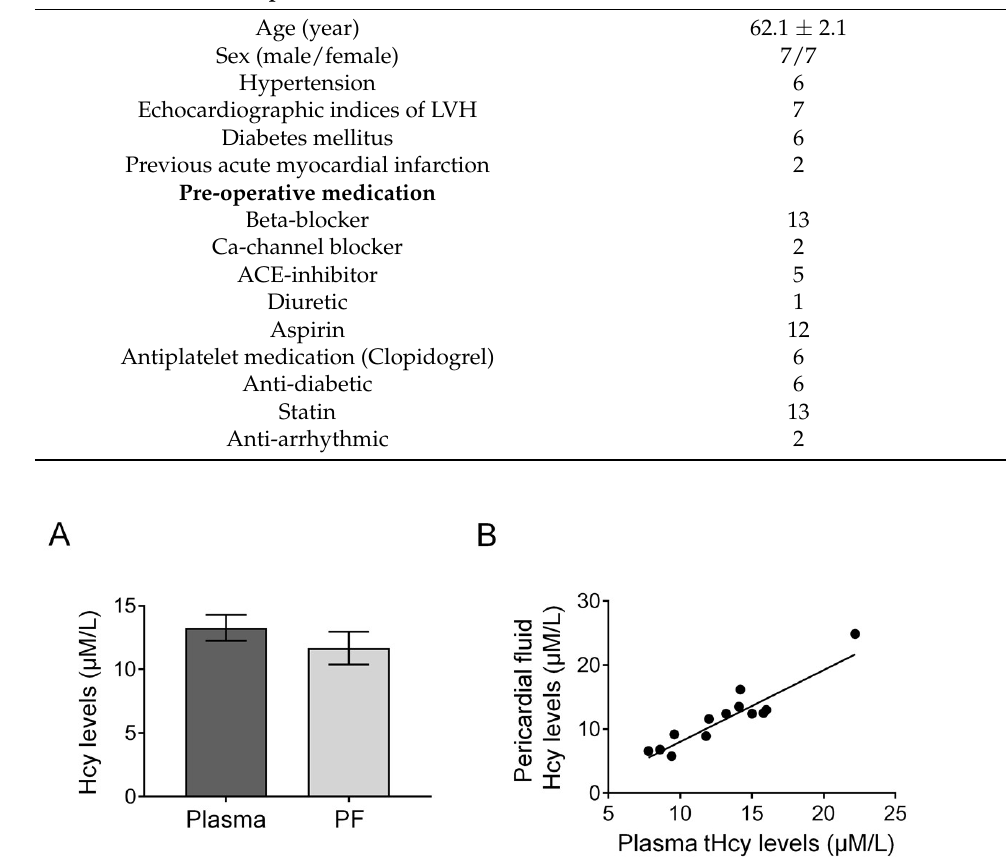
Figure 1. Data show that homocysteine levels of the plasma and pericardial fluid (PF) are similar and correlate to each other in patients undergoing CABG surgery ( n = 14). Two-tailed independent t -test showed no difference between plasma and PF tHcy levels ( p > 0.05) ( A ) Pearson’s correlation analysis showed a positive correlation between plasma and PF levels of CABG patients ( B ) y = 1.121x − 3.183, r = 0.9, p < 0.0001. PF—pericardial fluid, tHcy—total homocysteine; Data expressed as mean ± SEM; p < 0.05 was considered